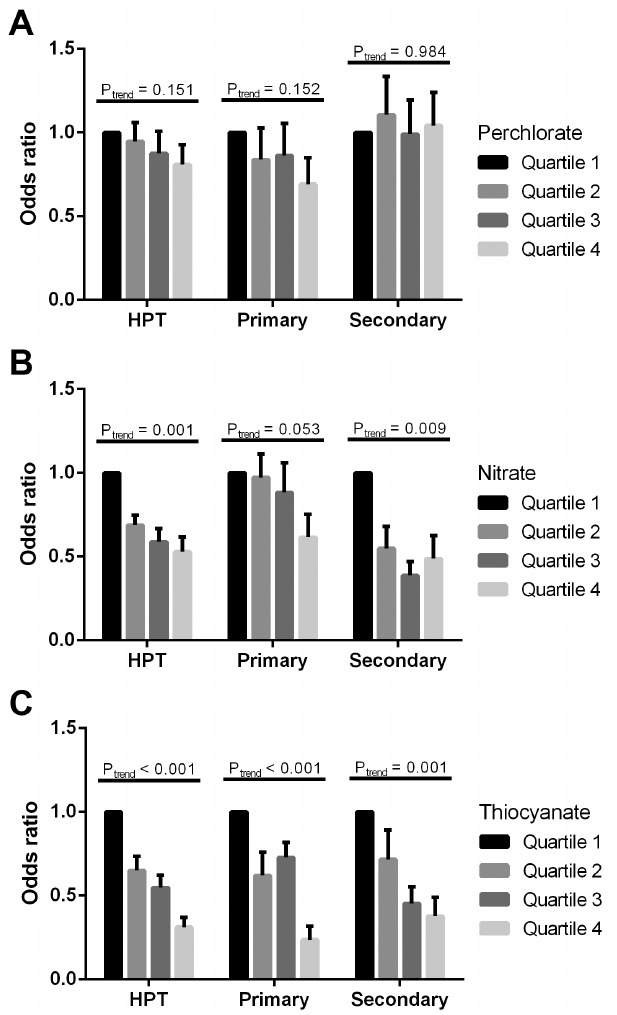
Fig. 2. Adjusted odds ratio ¡ SE for hyperparathyroidism (HPT, defined as parathyroid hormone . 70 pg/mL) by creatinine-corrected urinary concentrations of perchlorate, nitrate, and thiocyanate among the United States adults, NHANES 2005–2006. Primary HPT was arbitrarily defined as albumin-corrected total serum calcium $ 9.5 mg/dL, and secondary HPT was defined as corrected calcium , 9.5 mg/dL. A , Odd ratios by urinary perchlorate quartiles. B , Odd ratios by urinary nitrate quartiles. C , Odd ratios by urinary thiocyanate quartiles. Adjusted for age, race/ethnicity, smoking status, body mass index, corrected total serum calcium, and 25-hydroxyvitamin D